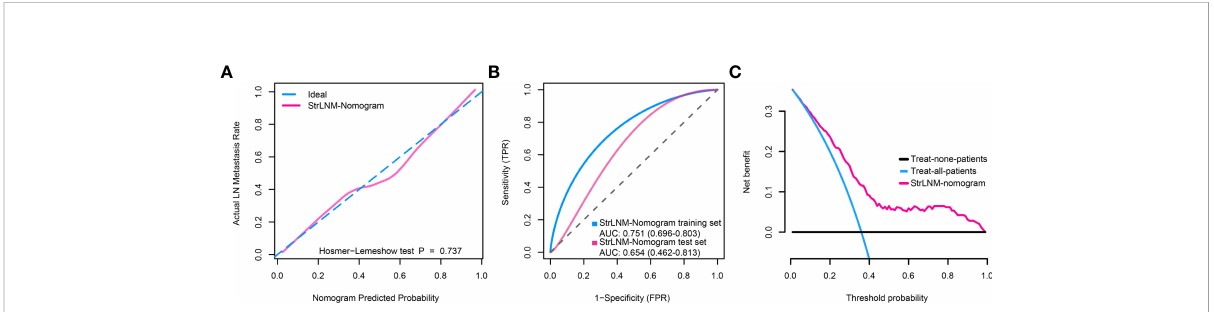
FIGURE 6 Clinical utility of the StrLNM nomogram. (A) Calibration curve of the StrLNM nomogram in the training dataset of the TCGA-BLCA cohort, which depicts the calibration of the fi tted model between the predicted risk of LN metastasis and actual LN metastasis rate. The x-axis represents the predicted LN metastasis risk, and the y-axis represents the actual LN metastasis rate. The pink solid line represents the performance of the StrLNM nomogram, of which a closer fi t to the diagonal dotted blue line represents an ideal prediction. The difference in the two models was measured with the Hosmer-Lemeshow test. (B) ROC curves showed the prediction accuracy of the StrLNM signature in prediction of the LN metastasis in training and testing datasets of the TCGA-BLCA cohort. (C) Decision curve analysis (DCA) for the StrLNM nomogram. The y-axis measures the net bene fi t. The pink line represents the StrLNM nomogram, the blue line represents the assumption that all patients have LN metastases, and the black line on the bottom represents the assumption that no patients have LN metastases.